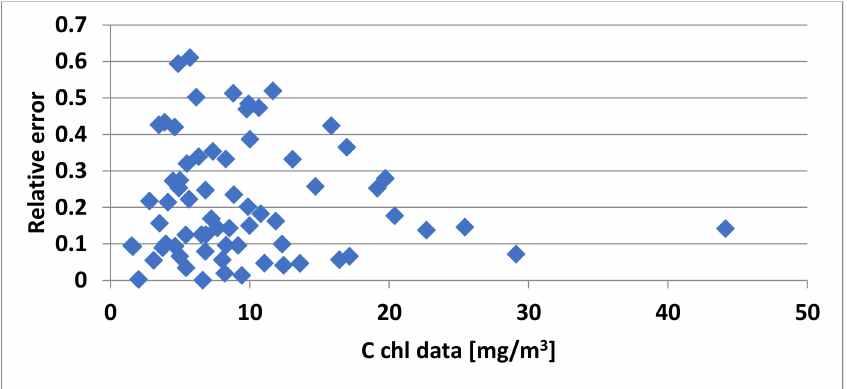
Figure 23. Model relative errors for chlorophyll a versus measurement